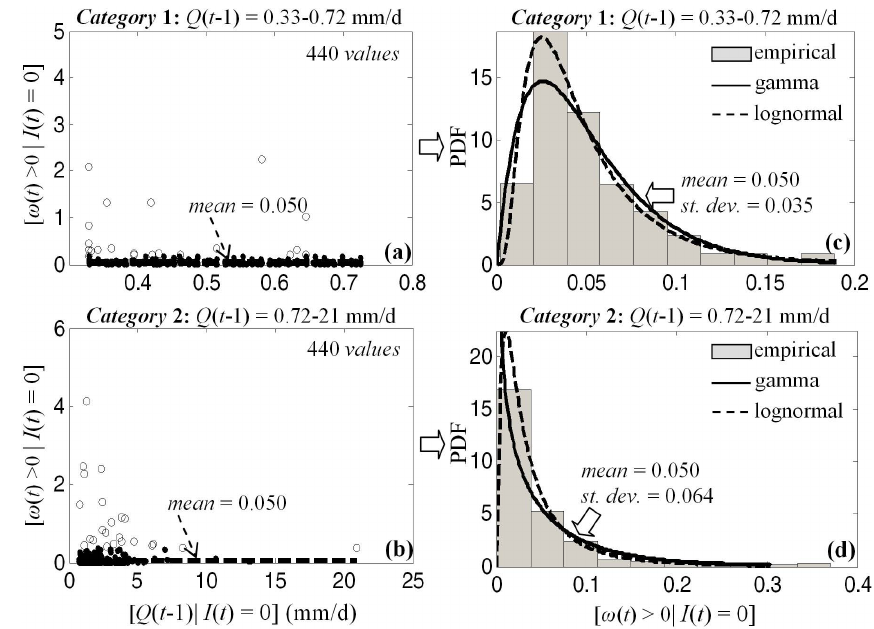
Fig. 5. Same as Fig. 4 but using daily rainfall intensities from the location of Moira (point C in Fig. 2) for the period 1 October 1975– 30 September 1993 (i.e. 18yr, 880 points).